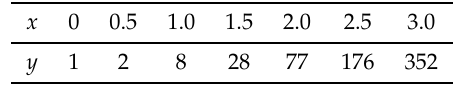
Table 3. Convex set of values.